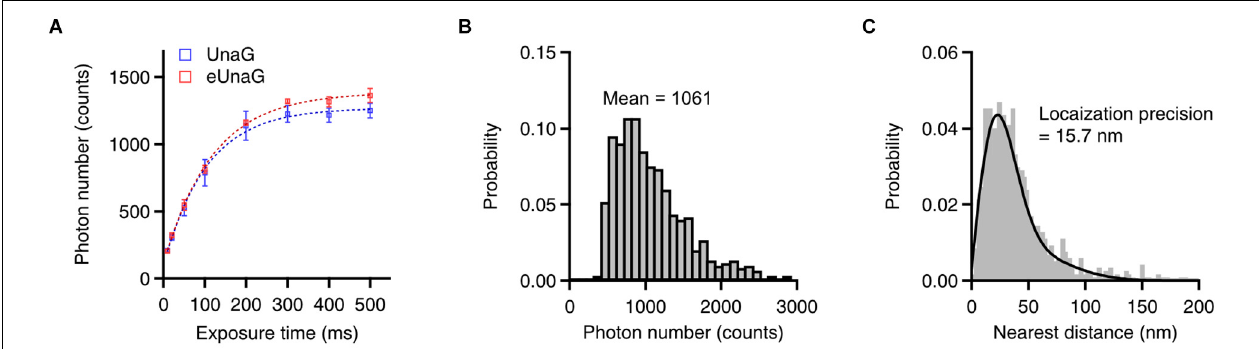
FIGURE 3 | Single-molecule switching characteristics of eUnaG. (A) Measured photon counts with different exposure times ( n = 8 independent measurements). The saturation levels of photon counts were 1,270 and 1,390 for UnaG and eUnaG, respectively, indicating a slightly higher photon number of eUnaG. (B) Photon number distribution of eUnaG with 200 ms of exposure time, showing 1,061 mean photon counts corresponding ∼ 22 nm of theoretical spatial resolution. (C) Resolution measurement by the nearest neighbor analysis yielded ∼ 16 nm of spatial resolution from repetitive localization of eUnaG. Error bars: SDs.